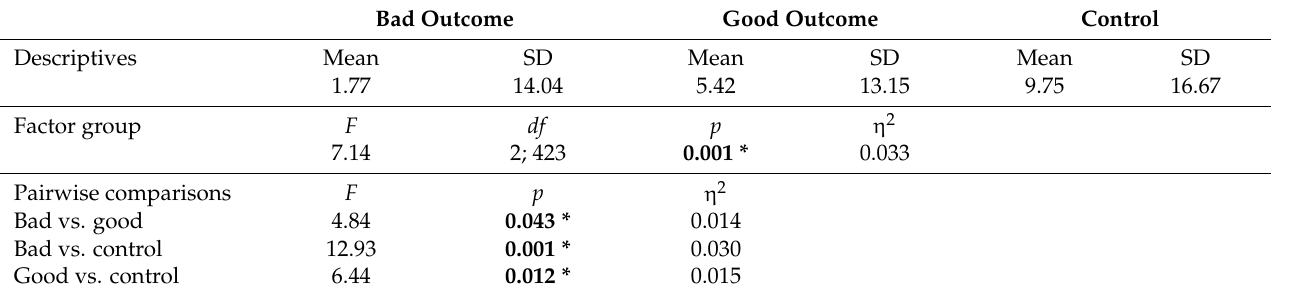
Table 2. Comparison of the IGT learning global score: ANCOVA adjusted by age and education. Bad Outcome Good Outcome Control